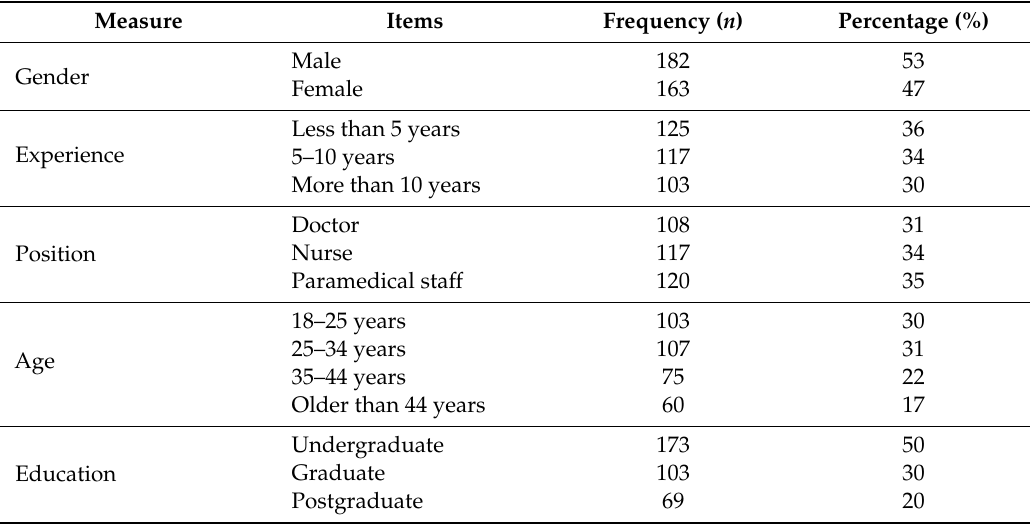
Table 1. Sample characteristics.